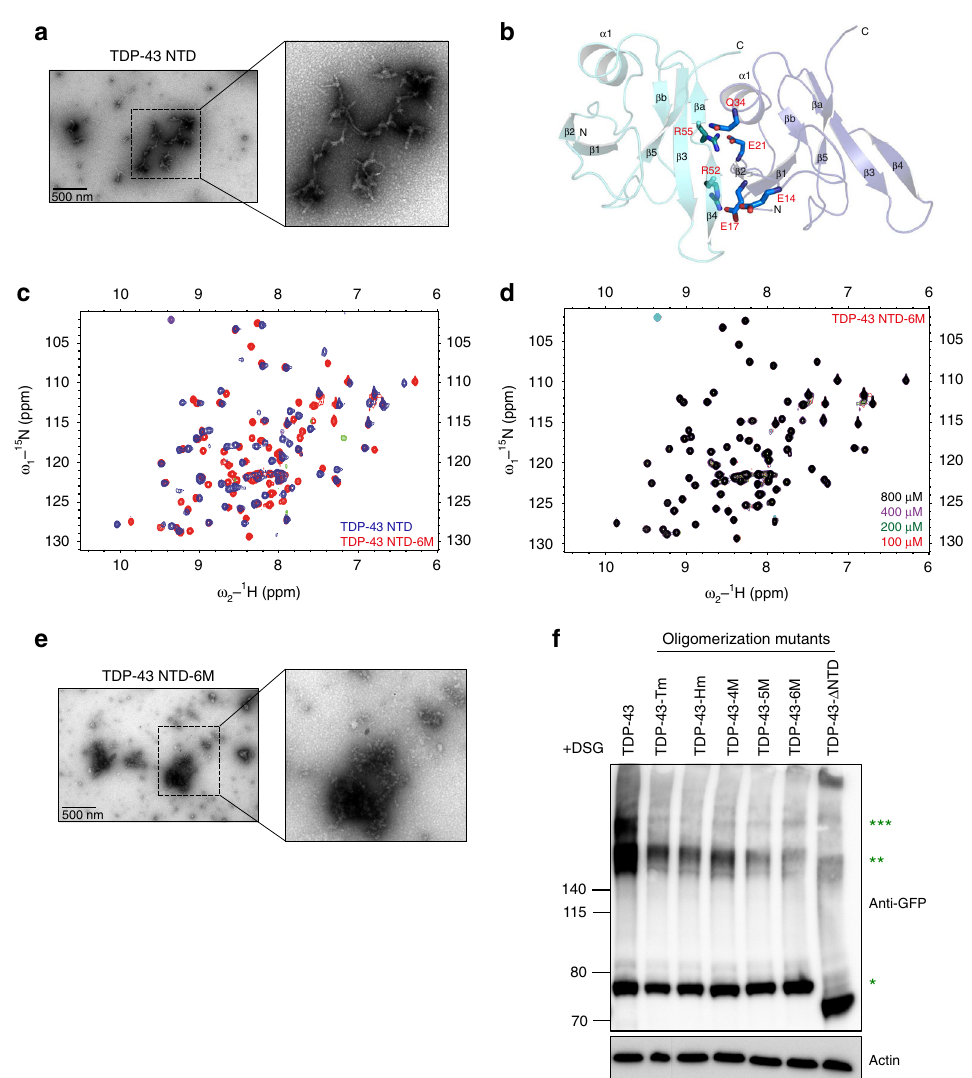
****** Fig. 4 Point mutations at oligomerization interface abrogate TDP-43 polymerization in vitro and in cells. a Transmission electron microscopy (TEM) image of TDP-43 NTD fi brillar oligomers following negative staining. One region ( dotted black box ) from the image is shown magni fi ed on the right . b Position of the six amino acids that were substituted to abolish oligomerization are shown on the cartoon of TDP-43 NTD crystal structure with side chains shown as sticks and labeled in red . c Overlay of 2D 1 H- 15 N HSQC spectra of wild type TDP-43 NTD ( blue ) and oligomerization mutant TDP-43 NTD- 6M ( red ) at protein concentration of 100 μ M at 30 °C. d Overlay of 2D 1 H- 15 N HSQC spectra of TDP-43 oligomerization mutant TDP-43 NTD-6M at increasing protein concentration of 100, 200, 400, and 800 μ M in red , green , magenta and black , respectively at 30 °C. e TEM image showing the lack of fi brillar structures for the oligomerization mutant TDP-43 NTD-6M. One region ( dotted black box ) from the image is shown magni fi ed on the right . f Immunoblots (from 4 – 12% denaturing polyacrylamide gel) with anti-GFP antibody ( upper panel ) of lysates obtained from cells transiently expressing wild- type GFP-tagged human TDP-43 (GFP-TDP-43) or oligomerization mutants (GFP-TDP-43-Tm/Hm/4M/5 M/6 M/ Δ NTD) followed by DSG-mediated cross-linking. Oligomerization mutants display signi fi cantly reduced high-molecular weight oligomeric TDP-43 compared to wild-type TDP-43. Actin is used as protein loading control ( lower panel ). Immunoblots are representative of three independent